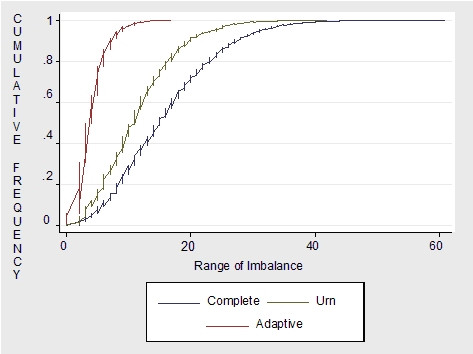
Adaptive (2 covariates), urn and complete randomization (n = 264, treatments = 3, simulations = 1000).